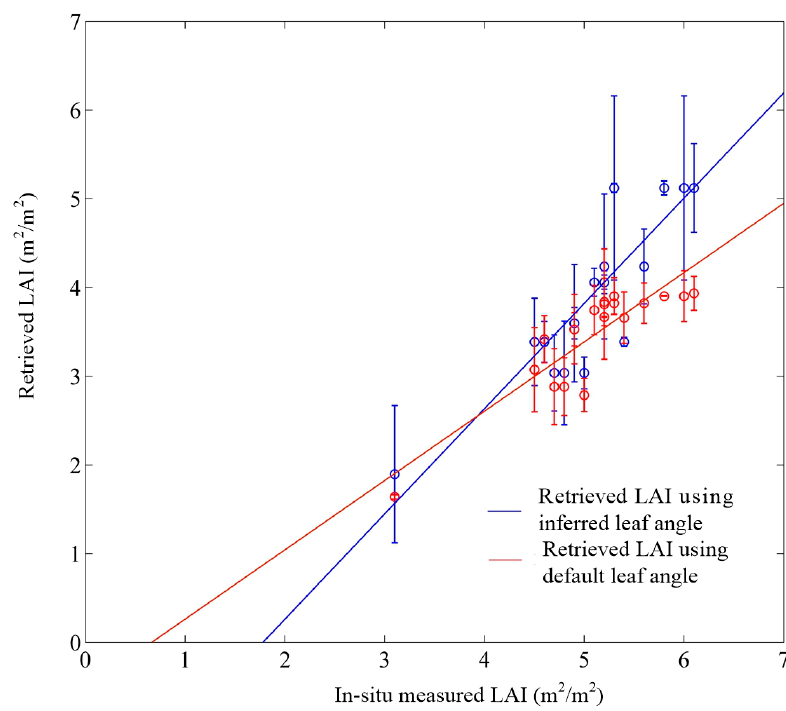
Figure 8. The relationships between the in-situ measured LAI and the retrieved LAIs using inferred and default leaf angle function. Values represent means ± SD based on the in-situ LAI measurements at each sample plot.